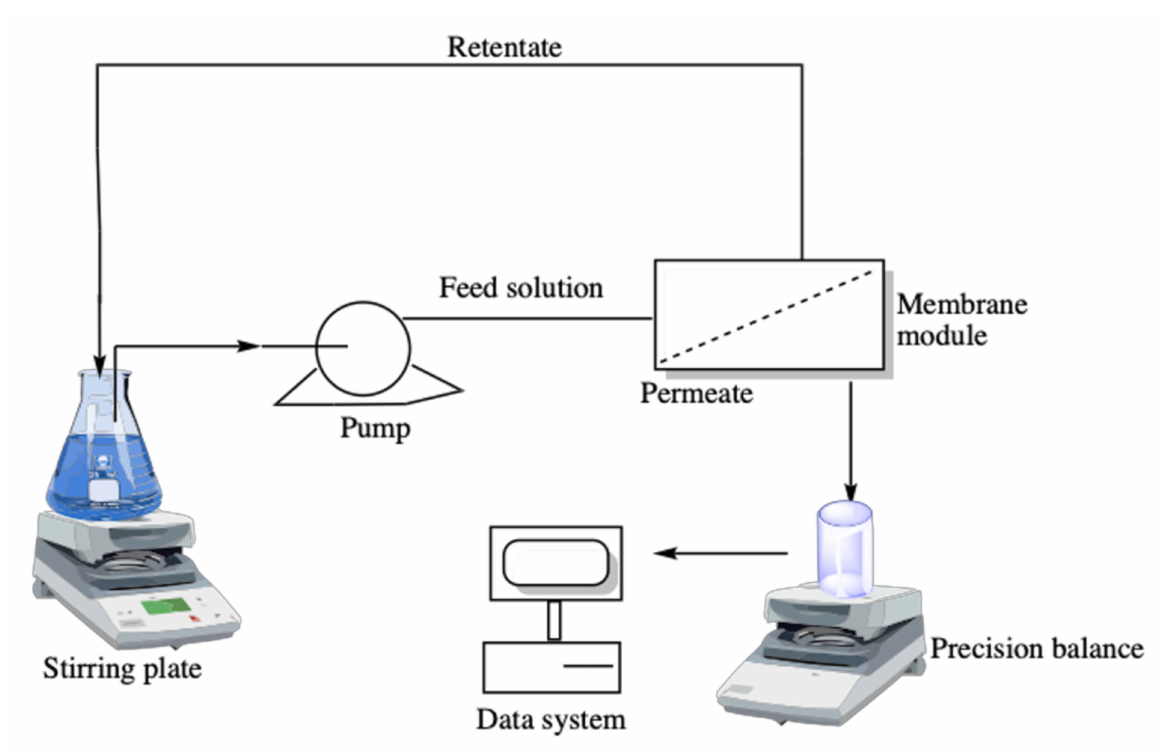
Figure 1. Schematic diagram of the membrane filtration